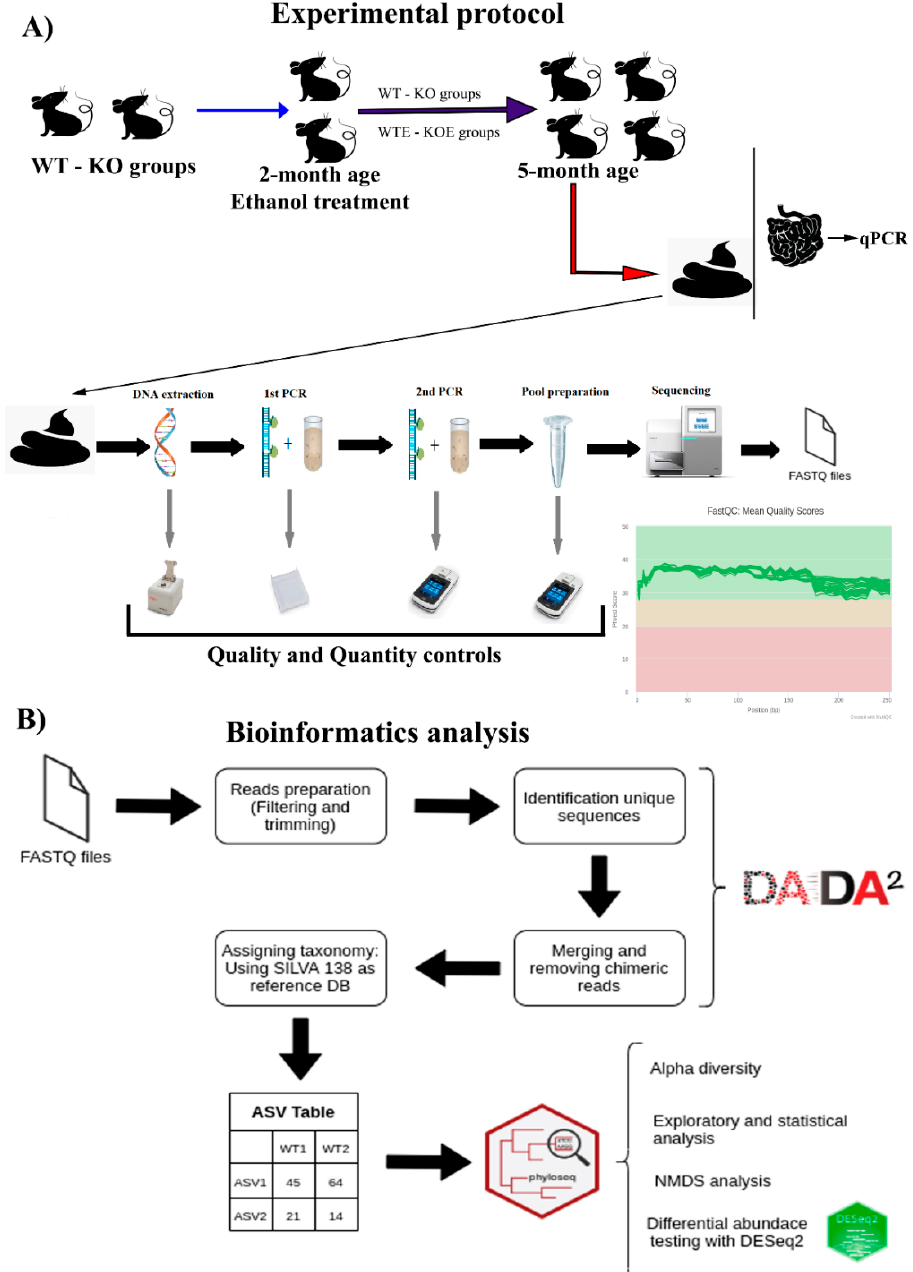
Figure 8. Schematic workflow of the experimental design and analysis. ( A ) Male mice with a CC57BL/6J background, with and without the deletion of TLR4, were either subjected to water containing 10% ( v / v ) alcohol at the 2 month time point or maintained as parallel untreated controls. Stool and colon tissues were collected from all the mice at 5 months. DNA was extracted from feces, and genomic 16S rRNA was sequenced. ( B ) ASVs were aligned to reference databases and analyzed for alpha diversity, NMDS, differential abundance and statistical analysis.